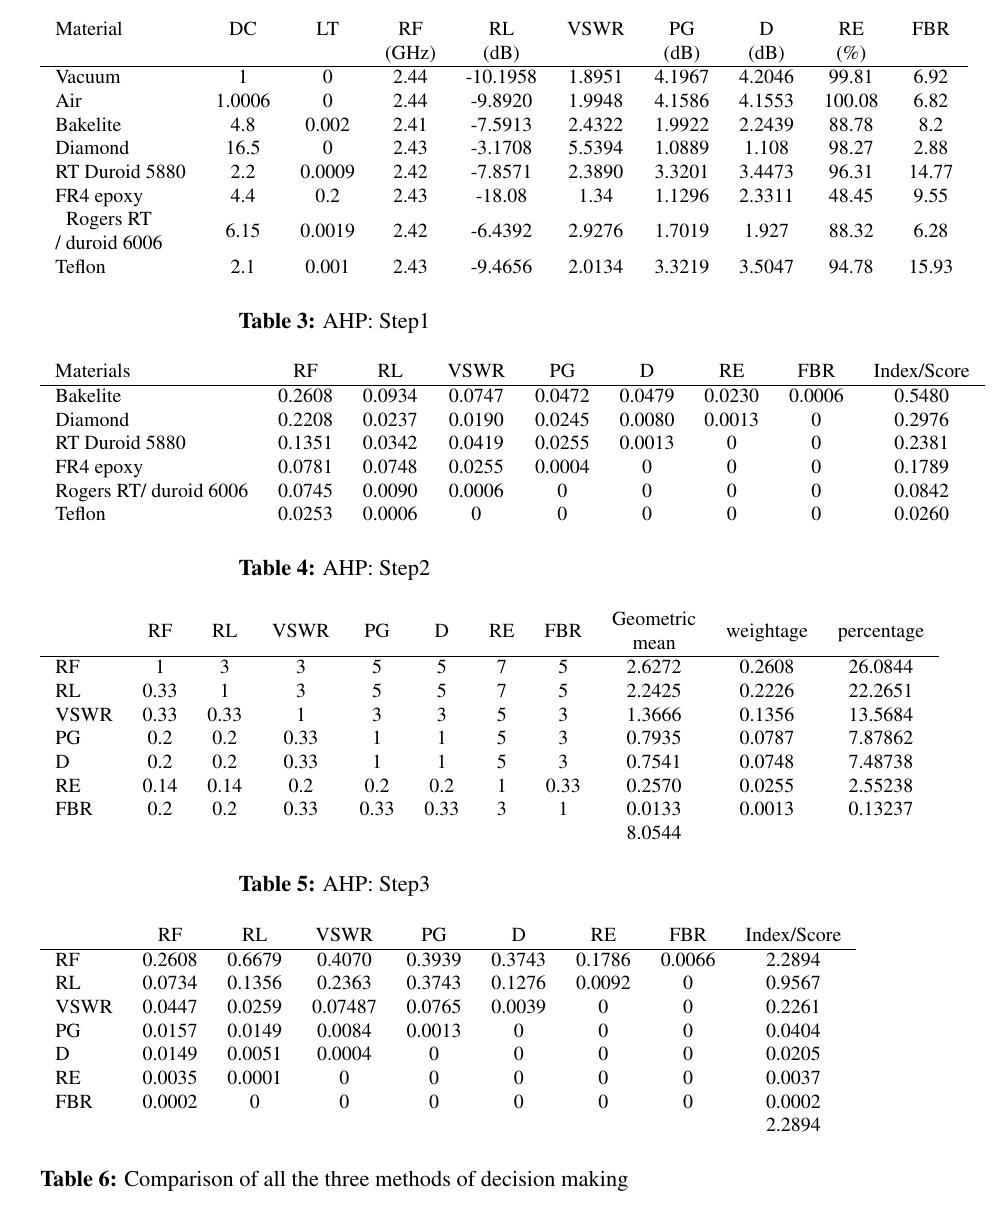
Table 2: Selection of Substrate Material